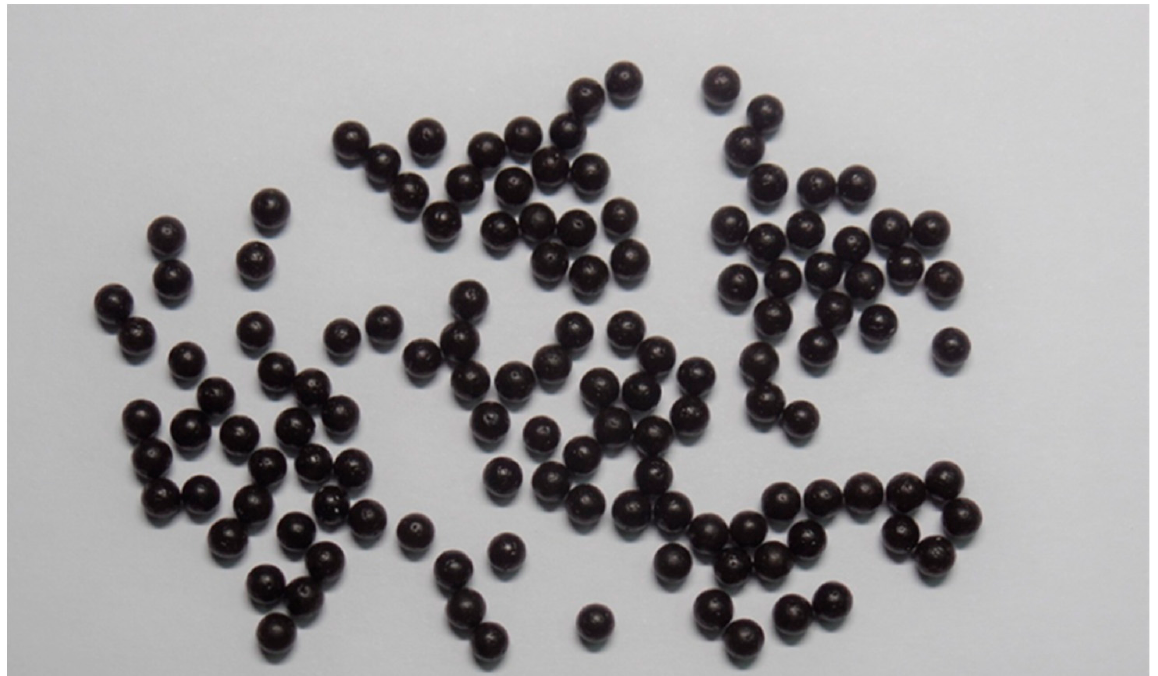
Figure 11. Appearance of the optimal formulation dropping pill .